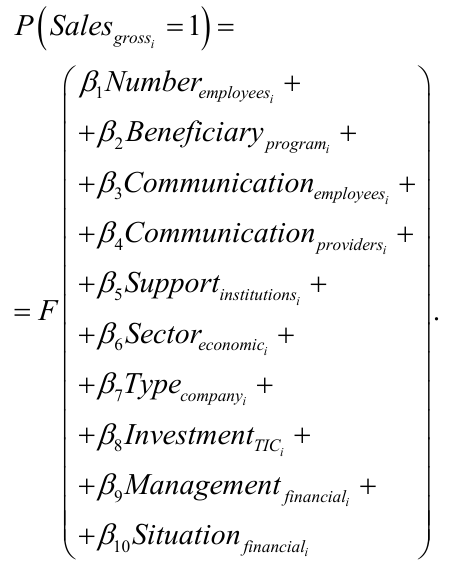
Table 3. Information